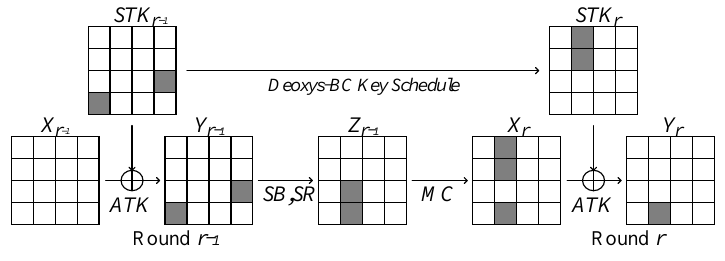
Figure 3: An example of consumption degrees Type